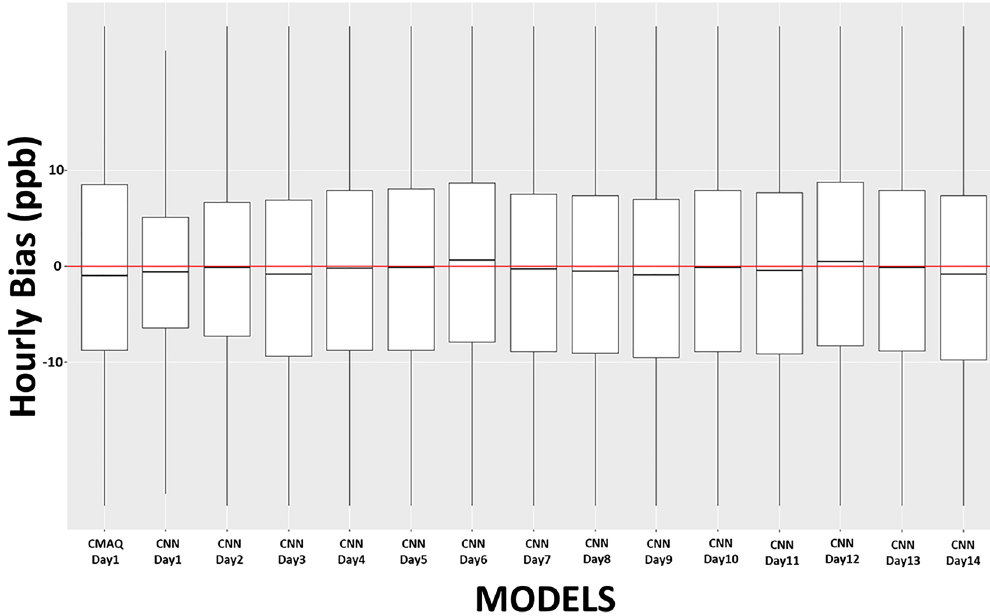
Figure 4. Box plot of hourly bias of all stations combined. The x-axis represents the prediction days, and the y-axis represents the hourly bias in ppb. The Redline represents the zero bias, and the black horizontal line in each box represents the mean bias for that